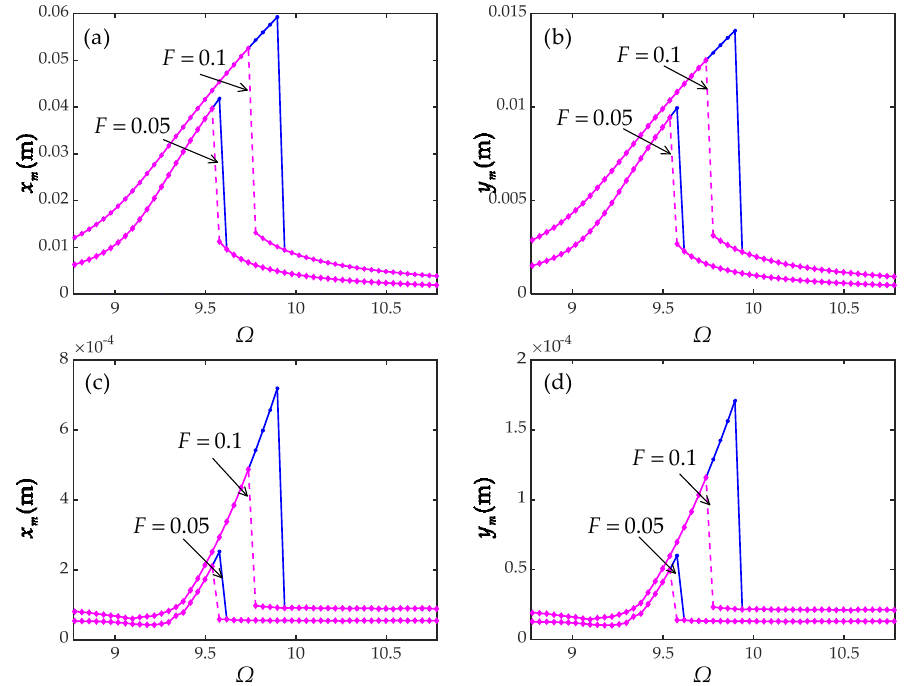
Figure 9. Frequency response curves for the first mode at Ω = ω 1 + εσ 2 and σ 1 = 0.01 without three-to-one internal resonance: ( a , b ) k N = 1.2 × 10 4 N · m/rad 3 ; ( c , d ) k N = 2.4 × 10 4 N · m/rad 3